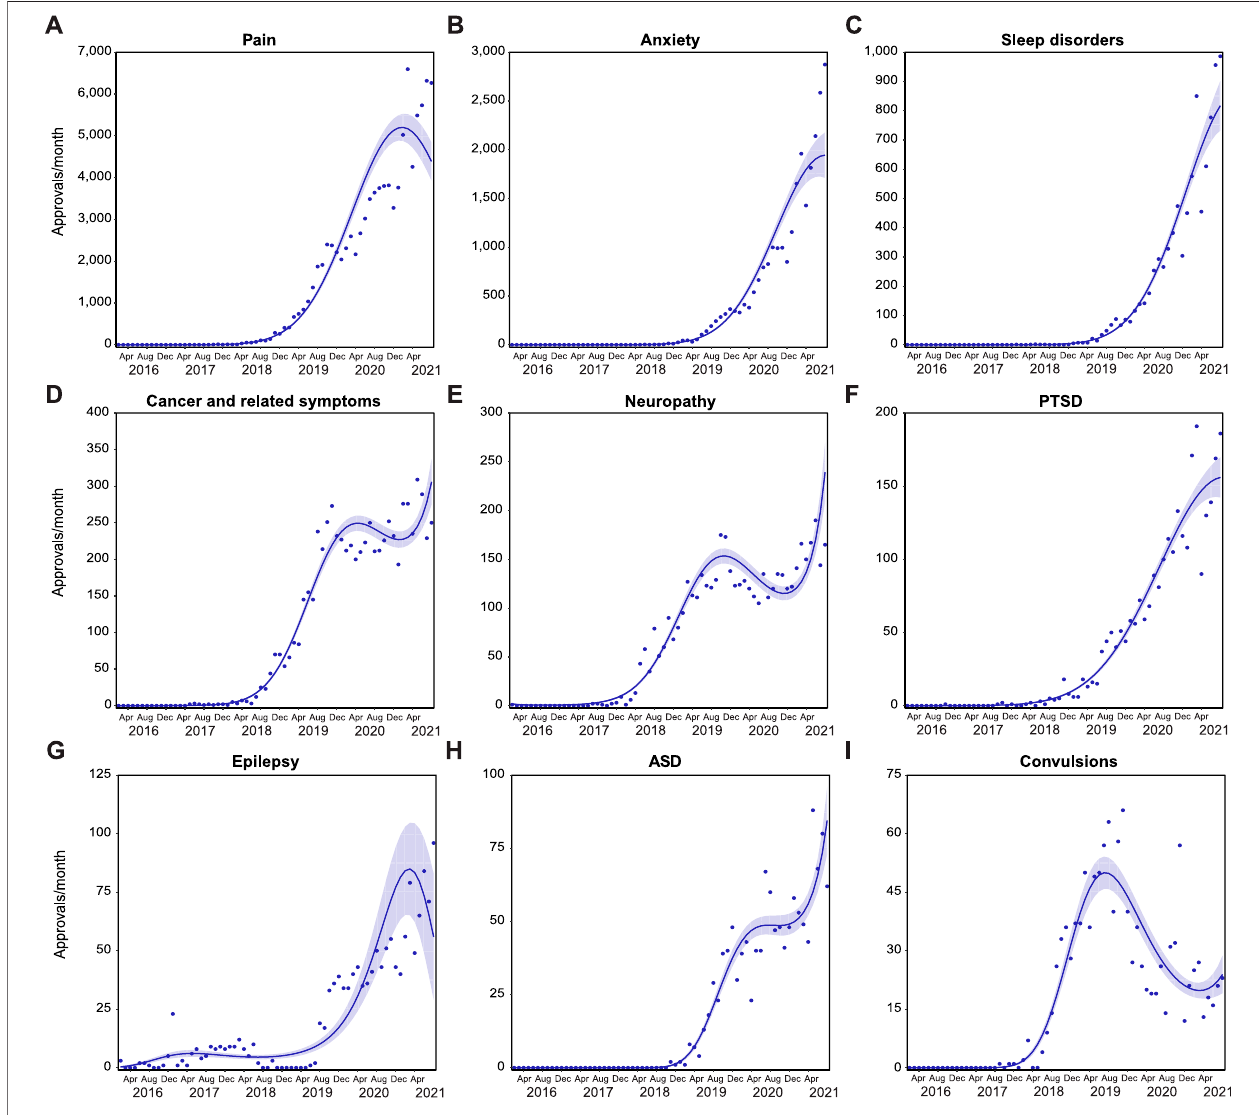
FIGURE 3 | Growth is varied across indication categories. Trends in monthly approvals over time were analyzed in ICD-10 indication categories with > 1,000 cumulative approvals ( Supplementary Table S1 ). Approvals for pain (A) ; anxiety (B) ; sleep disorders (C) ; and PTSD (F) followed Negative binomial, 2nd degree polynomial curves (R 2 = 0.988, 0.989, 0.987, and 0.973, and Δ m = 13,202.020, 1,413.481, 51.913, and 54.544, respectively). Approvals for cancer and related symptoms (D) ; and neuropathy (E) followed Negative binomial 4th degree polynomial curve (R 2 = 0.981 and 0.962, and Δ m = 17.271 and 21.698, respectively). Approvals for epilepsy (G) moderately followed a Negative binomial 4th degree polynomial curve (R2 = 0.587, Δ m = 7.922). Approvals for ASD (H) and convulsions (I) followed Negative binomial 3rd degree polynomial curves (R 2 = 0.977 and 0.918, and Δ m = 27.715 and 31.812, respectively). Solid lines represent the best fi t with shaded standard error of the